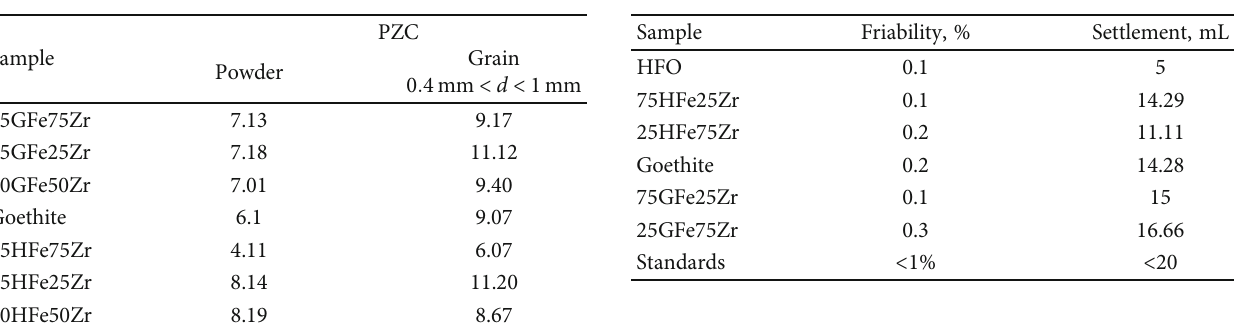
Figure 5: (a) SEM images and (b) EDX results of catalyst samples in grain form. Samples: (I) 25GFe75Zr, (II) 75GFe25Zr, (III) 25HFe75Zr, (IV) 75HFe25Zr. Table 4: pH of point of zero charge (PZC) of catalysts used in the degradation of 4-nitrophenol.